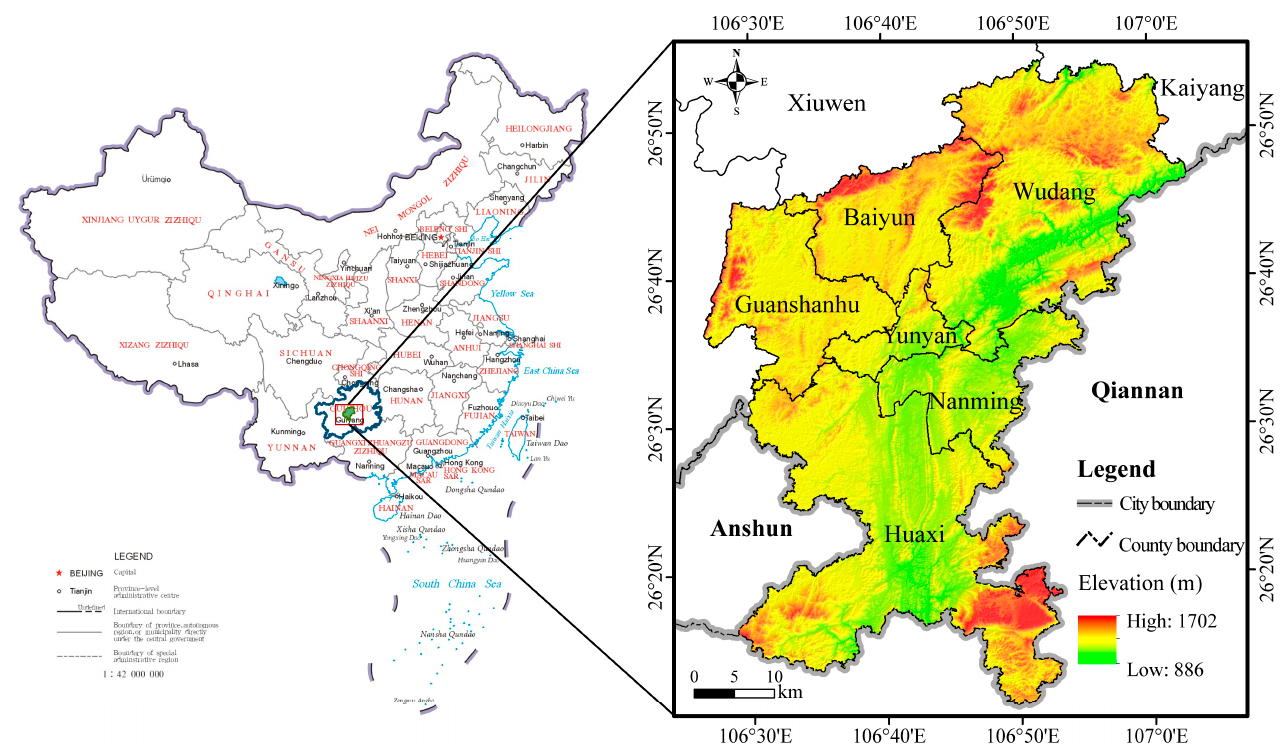
Figure 1. Location of the study site.